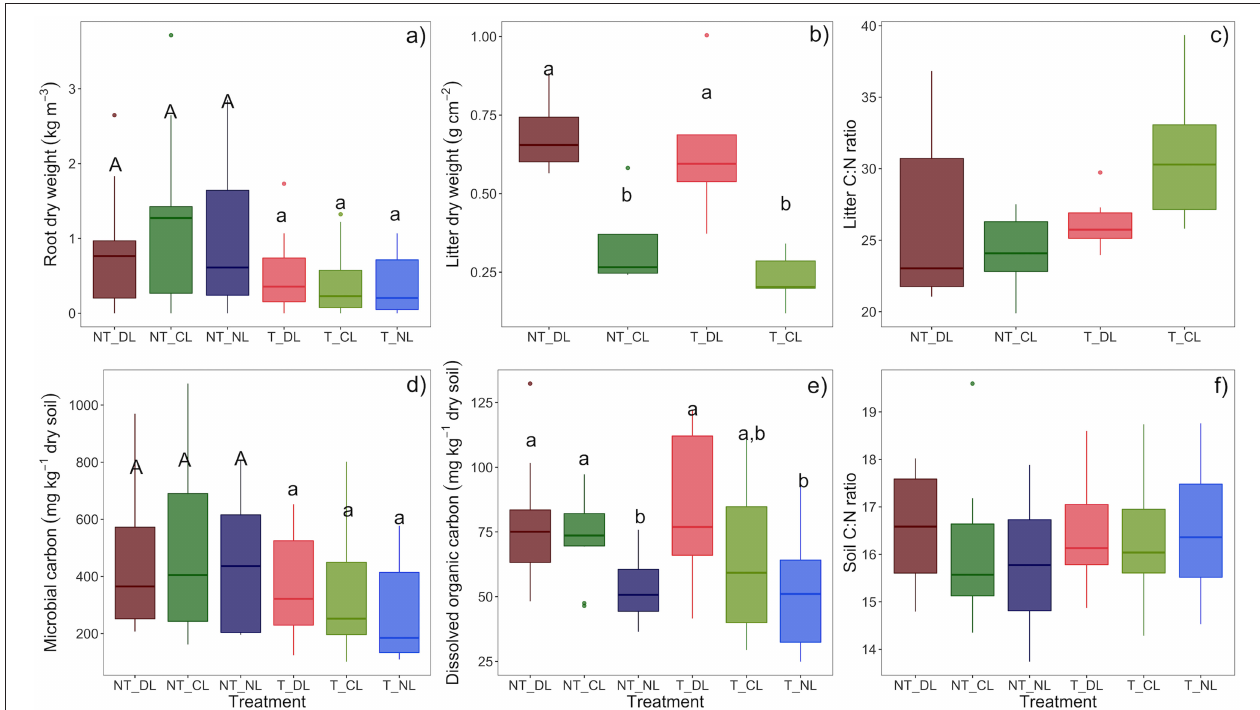
FIGURE 2 | (a) Root biomass, (b) leaf litter biomass, (c) leaf litter C:N ratios, (d) microbial biomass carbon, (e) dissolved organic carbon, and (f) soil C:N ratios in each of the root and leaf litter input treatments. Averaged values of 0–5 and 5–10cm soil depths for the case of root and soil variables. Box-plots represent the values of n = 5 plots per treatment. Different letter case indicates significant effect of trenching according two-ways ANOVA. Different letters indicate significant differences among leaf litter input levels within each trenching level. Microbial biomass carbon is not corrected for extraction efficiency. NT_DL, Non-Trenched and Doubled Litter; NT_CL, Non-Trenched and Control Litter; NT_NL, Non-Trenched and No-Litter; T_DL, Trenched and Doubled Litter; T_CL, Trenched and Control Litter; T_NL, Trenched and No-Litter.